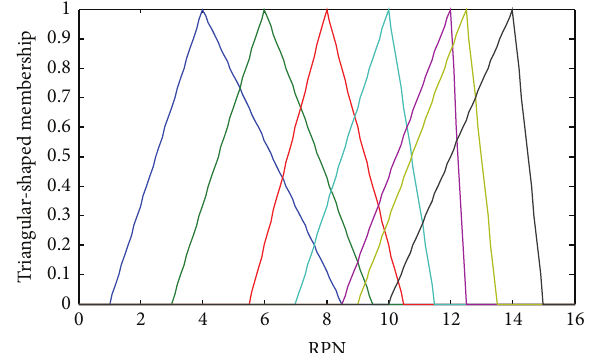
Figure 5: Triangular-shaped membership for environmental risk.